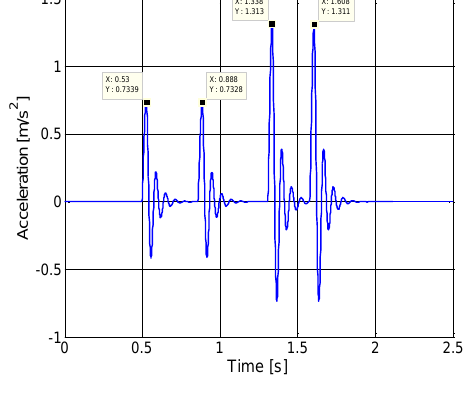
Fig. 13. Acceleration of mass m – linear case. Fig. 14. Acceleration of mass m – nonlinear case.